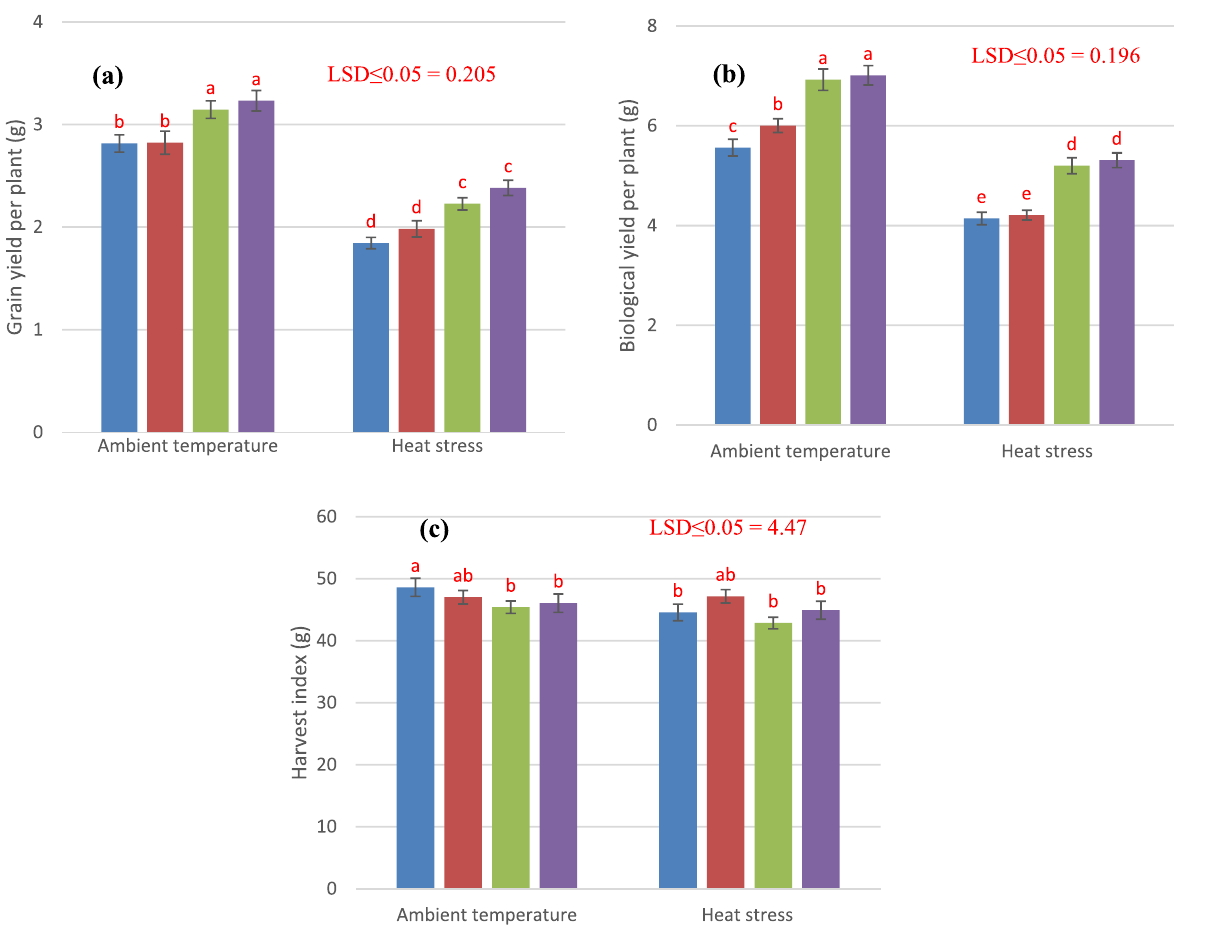
Figure 7. Influence of exogenously applied Si on grain yield ( a ), biological yield ( b ) and harvest index ( c ) of wheat under ambient temperature and heat stress. Values are the mean SE of four replicates.